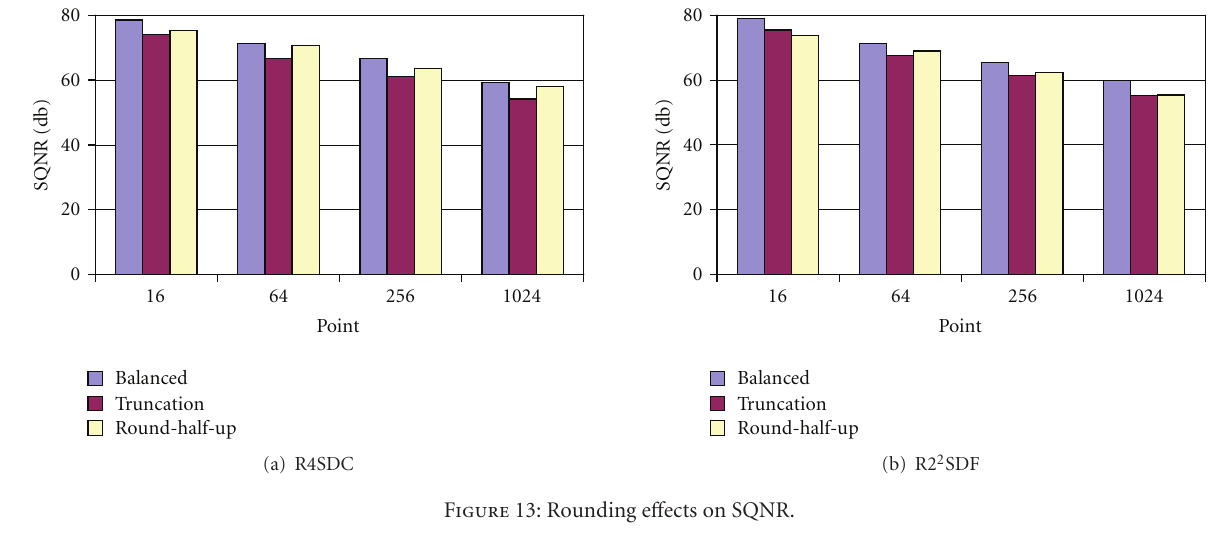
Figure 13: Rounding e ff ects on SQNR.